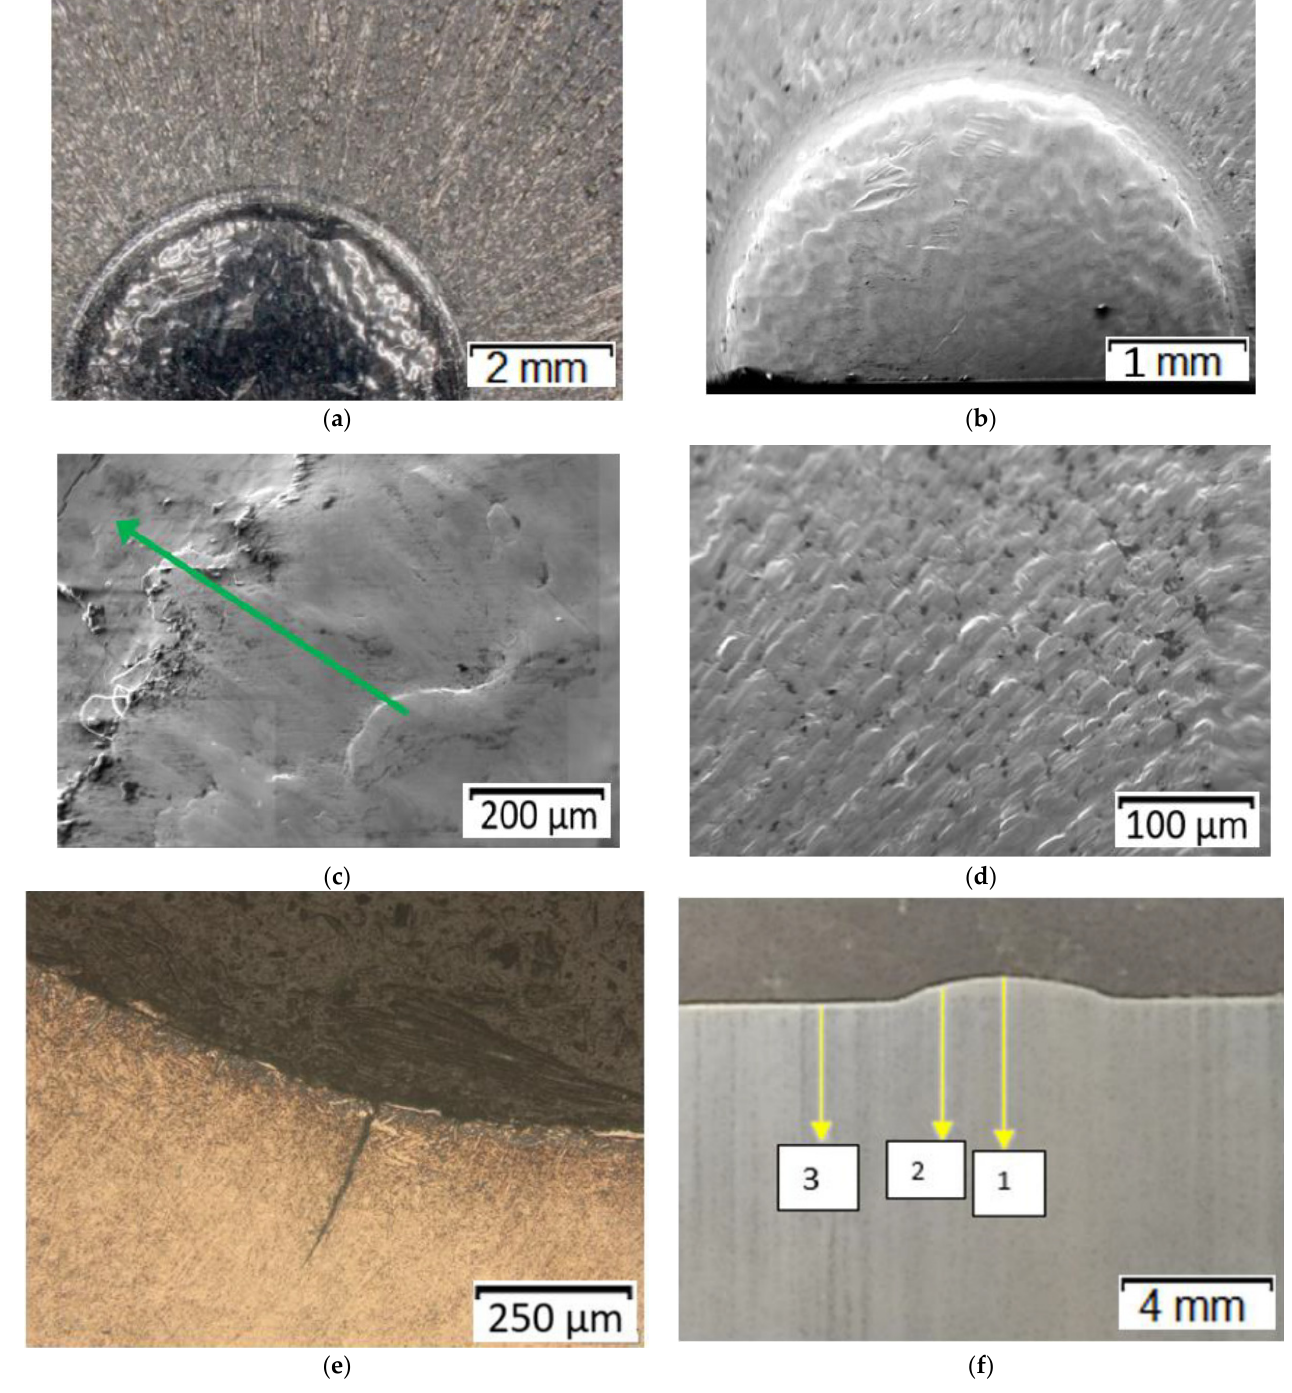
Figure 11. Microstructural analysis of the punch which produced 700 forgings: ( a ) macro-image of the calotte, ( b ) SEM analysis of the calotte (low magnification), ( c ) SEM image of the calotte—visible plastic deformations (green arrow shows the direction of plastic deformation), ( d ) SEM of the front surface—thermo-mechanical fatigue, ( e ) a micro-crack at the base of the calotte, ( f ) vectors of the hardness measurements.